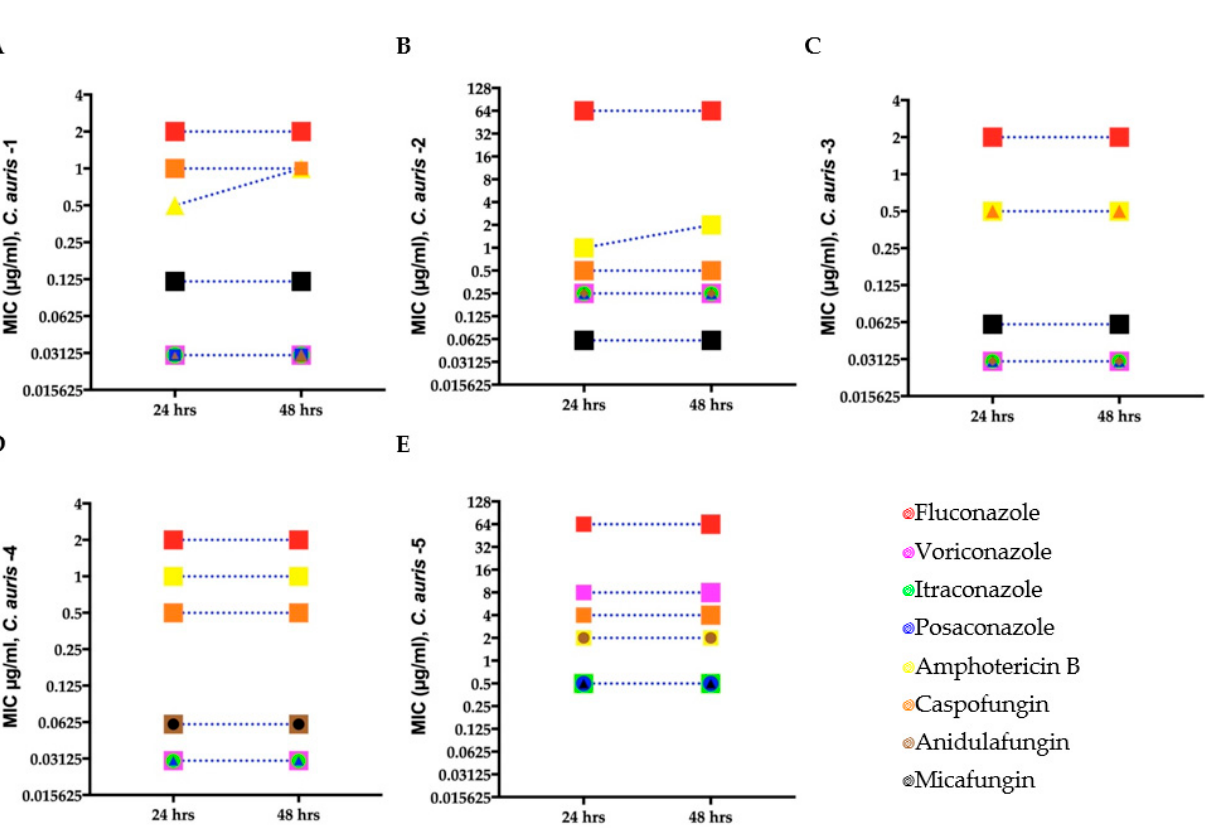
Figure 1. Minimum inhibitory concentration (MIC) for clinical C. auris isolates ( A – E ) growing in antifungal microwell plates to determine susceptibility/resistance to antifungal drugs. Mean MICs of five clinical C. auris isolates measured after 24 and 48 h for four fungistatic drugs (fluconazole, itraconazole, posaconazole, and voriconazole) and two fungicidal drugs (amphotericin B and caspofungin). Different symbols denote C. auris isolates with the same MIC.